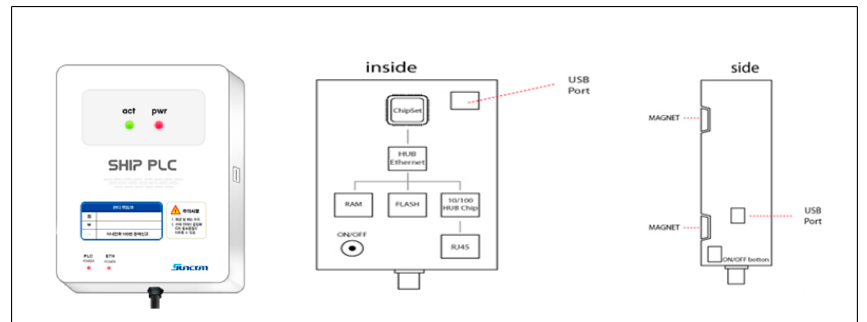
Figure 15. Diagram of the PLC repeater.